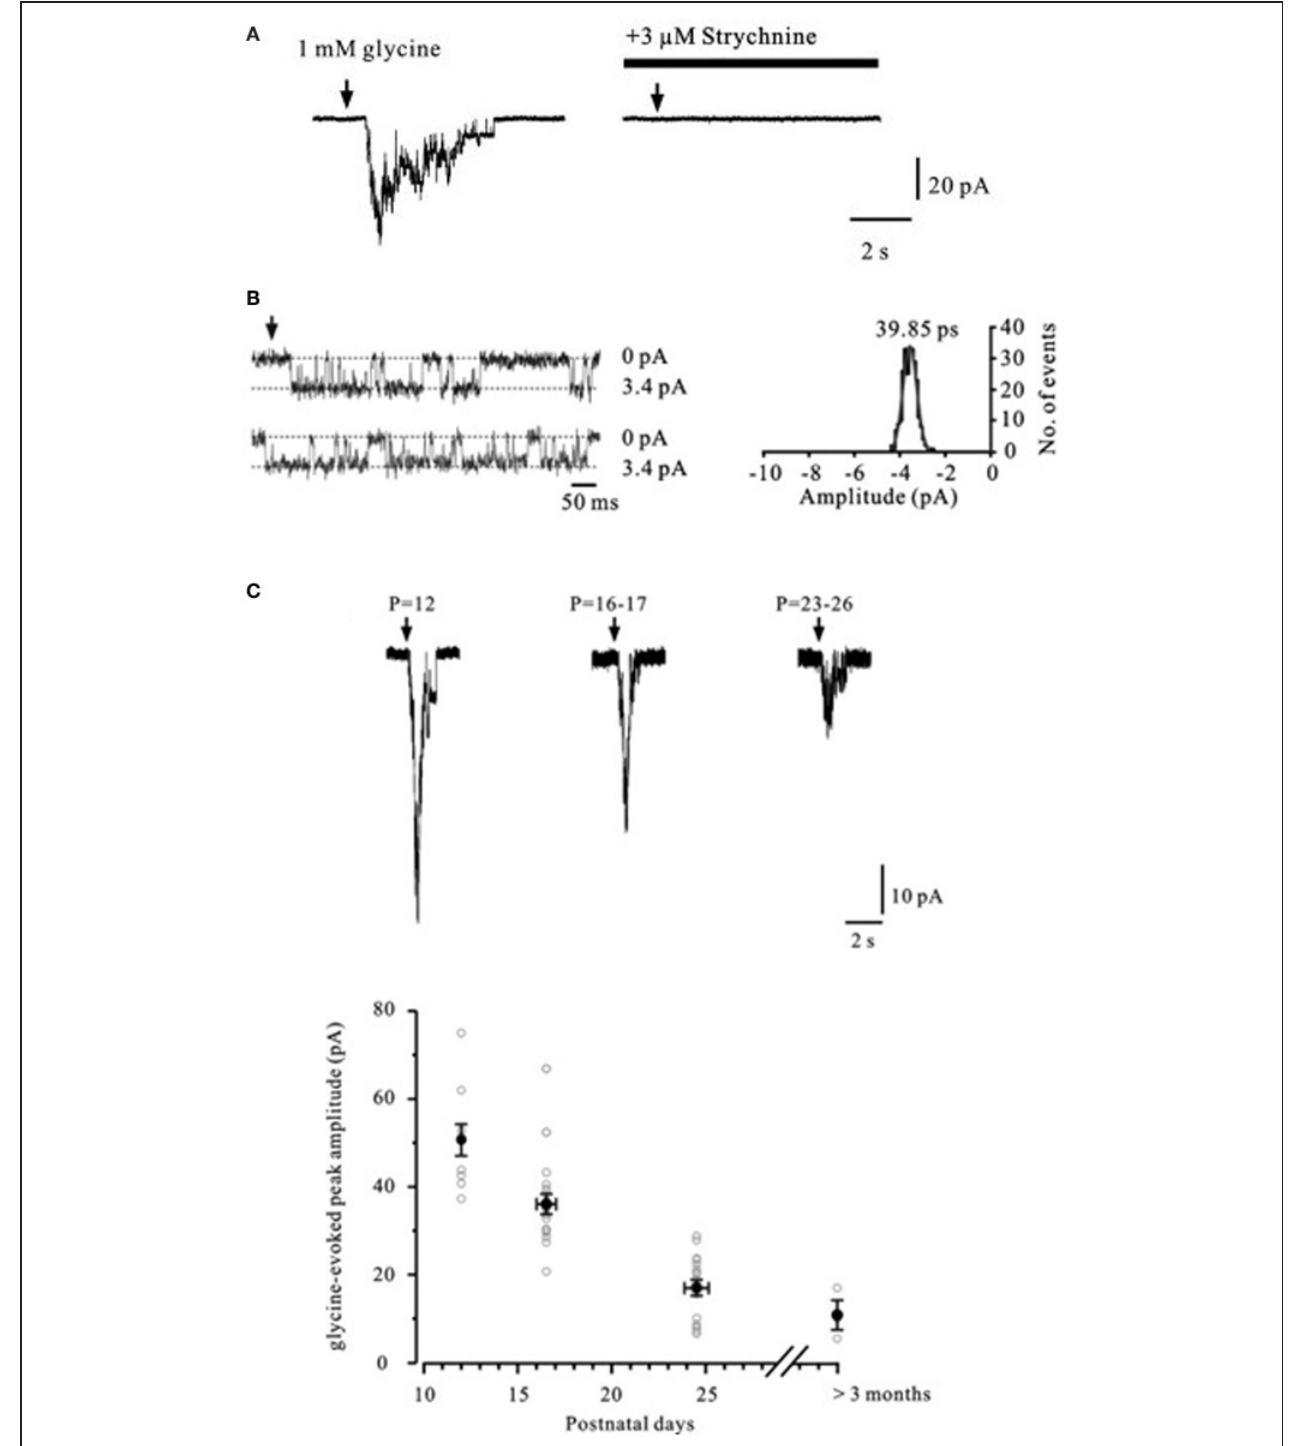
FIGURE 5 | Glycine-evoked currents in mossy fiber boutons. (A) Currents in a mossy fiber bouton evoked by focal application of 1mM glycine. Superfusion of the glycine receptor antagonist strychnine (3 μ M) completely blocks the current. Arrows indicate glycine puff-application. (B) Left, representative traces of single-channel currents in an isolated outside-out patch from a mossy fiber bouton (P12) evoked by continuous application of